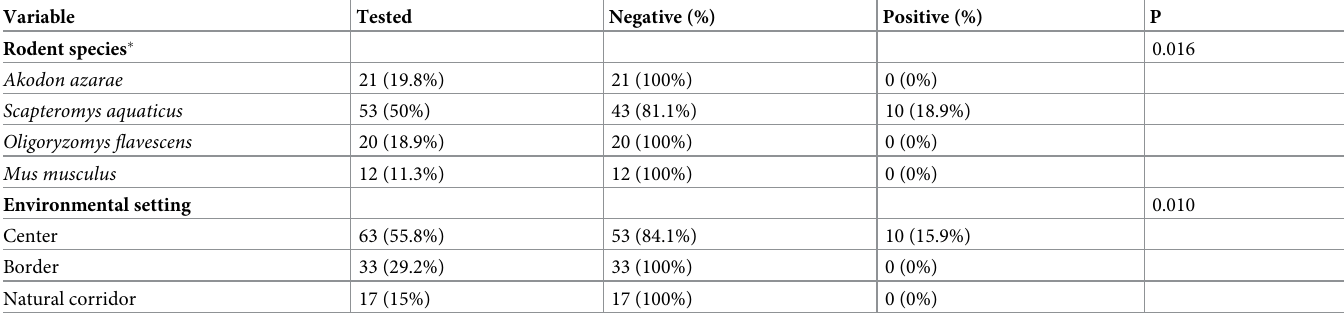
Table 3. Hantavirus seroprevalence in murid and sigmodontine rodents from riverside settlements of the Parana´ flooded savanna, Santa Fe´, Central Argentina, from 2014 to 2015. P: P-value of the Chi-square test.